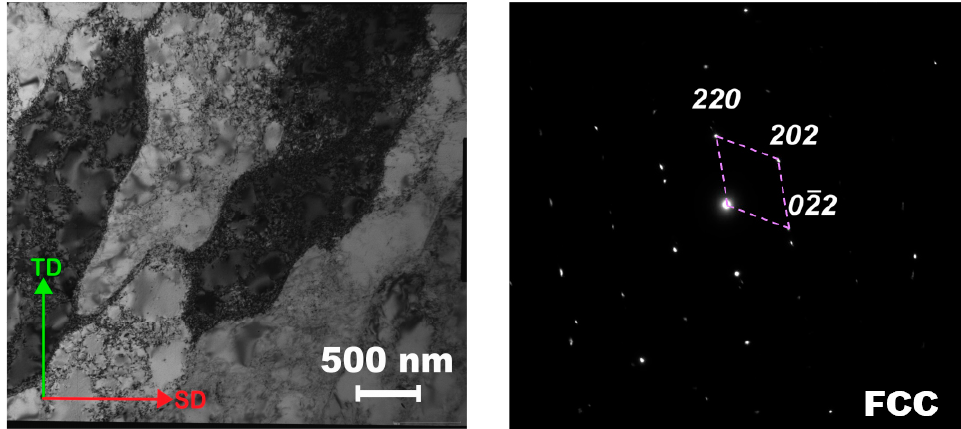
Figure 8. TEM image of the microstructure of the as-produced (mode: P = 200 W and V = 1600 mm/s) Fe 65 (CoNi) 25 Cr 9.5 C 0.5 alloy.